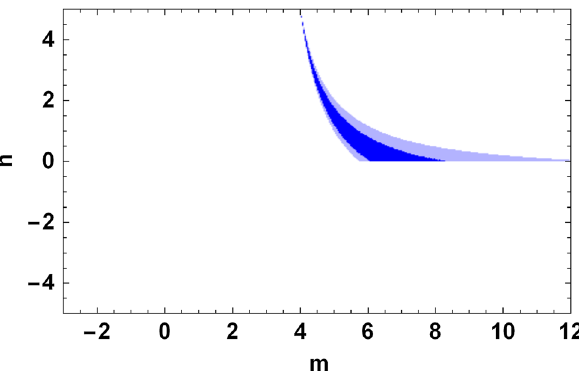
Fig. 1 Numerical values of the ( n , m ) parameters of the chameleon field driven warm inflation model in the weak dissipative regime for which the point ( r − n s ) is located in the observational region. The dark blue color shows the values of ( n , m ) in the 68% CL range of the Planck-2018 data, while the light blue color shows the parameter values in the range 95%